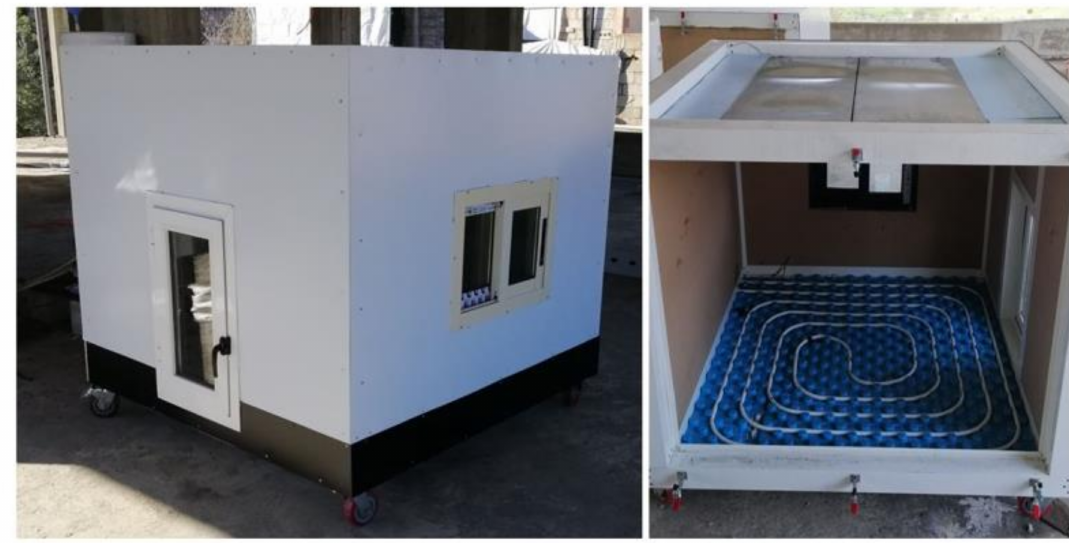
Figure 24. Real photo of a prepared prototype following the design proposed in the study.